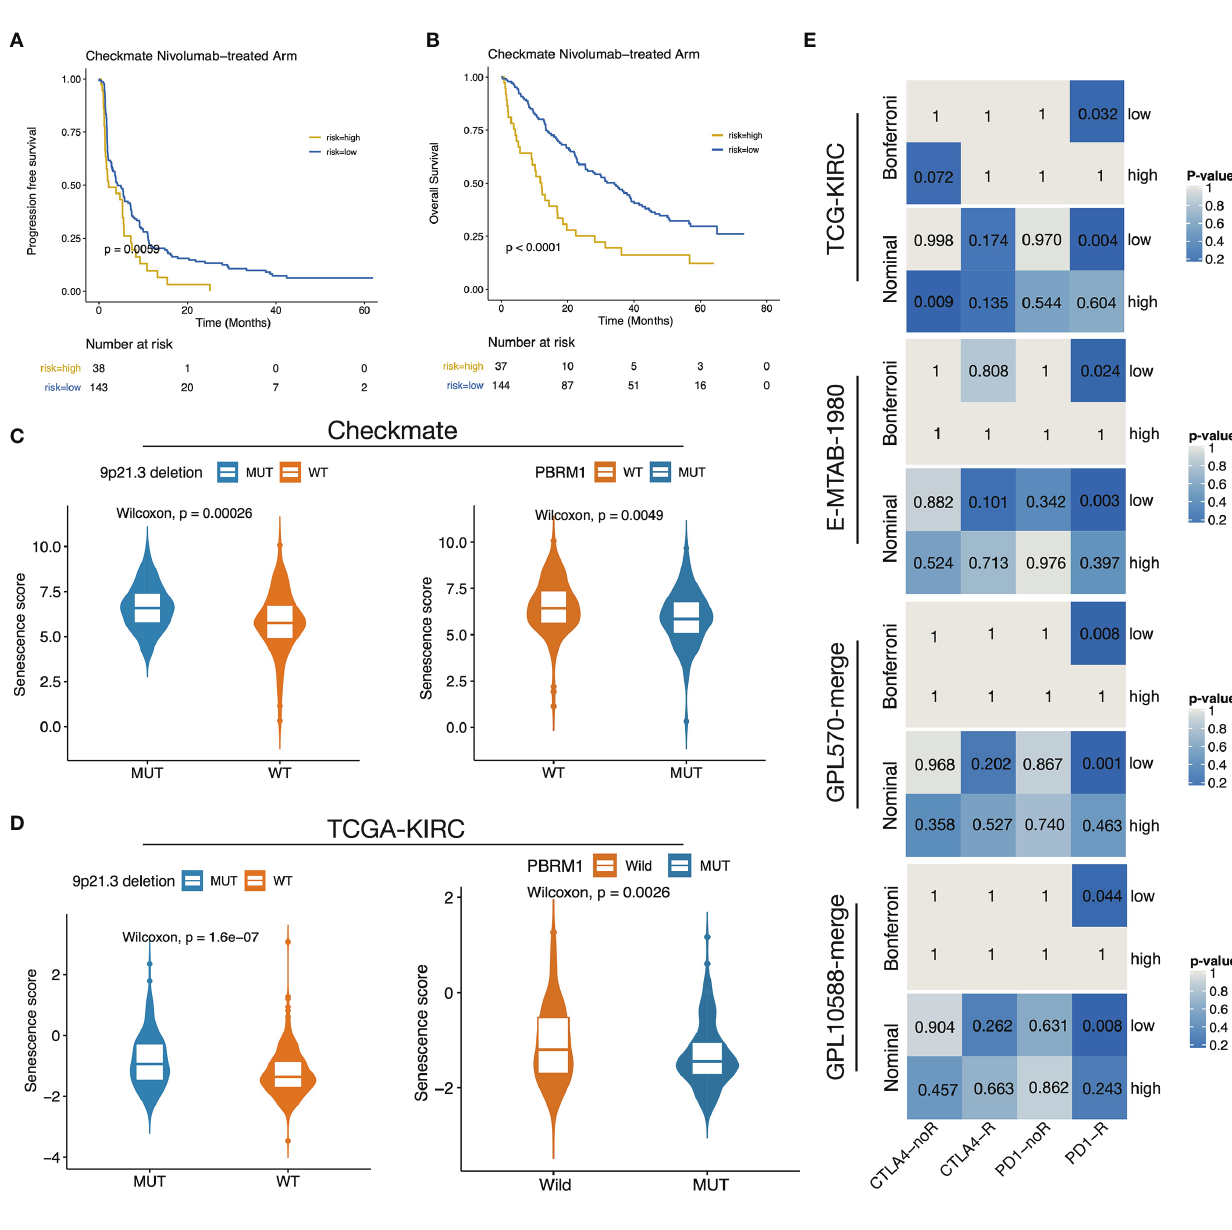
FIGURE 7 | The low senescence score subgroup was predicted to respond to anti – PD-1 treatment. (A, B) Survival curves showed that the high-score group determined by the surv_cutponit function gained PFS (A) and OS (B) bene fi ts. (C, D) The boxplot showed that 9p21.3 loss groups possess higher senescence scores while PRBM1 mutant groups possess lower senescence scores in Checkmate (C) and TCGA-KIRC (D) . (E) Subclass mapping results in TCGA-KIRC, E- MTAB-1980, GPL570-merge, and GPL10588-merge datasets using a melanoma dataset treated with anti-CTLA4/PD-1 as a